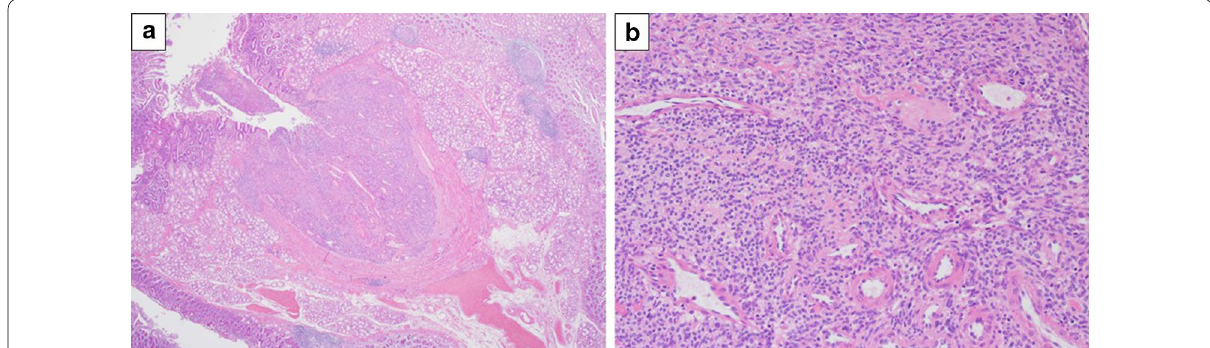
Fig. 5 Histological examination shows uniform small round cells with central nuclei and a pale cytoplasm (glomus cell) with perivascular proliferation. a Hematoxylin and eosin stain